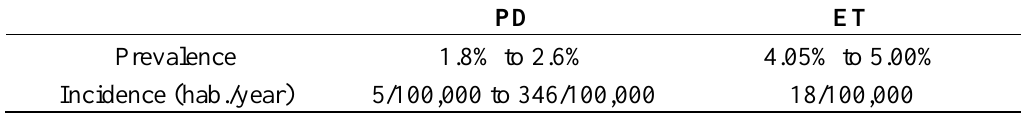
Table 1. Range of prevalence and incidence rates from different European studies